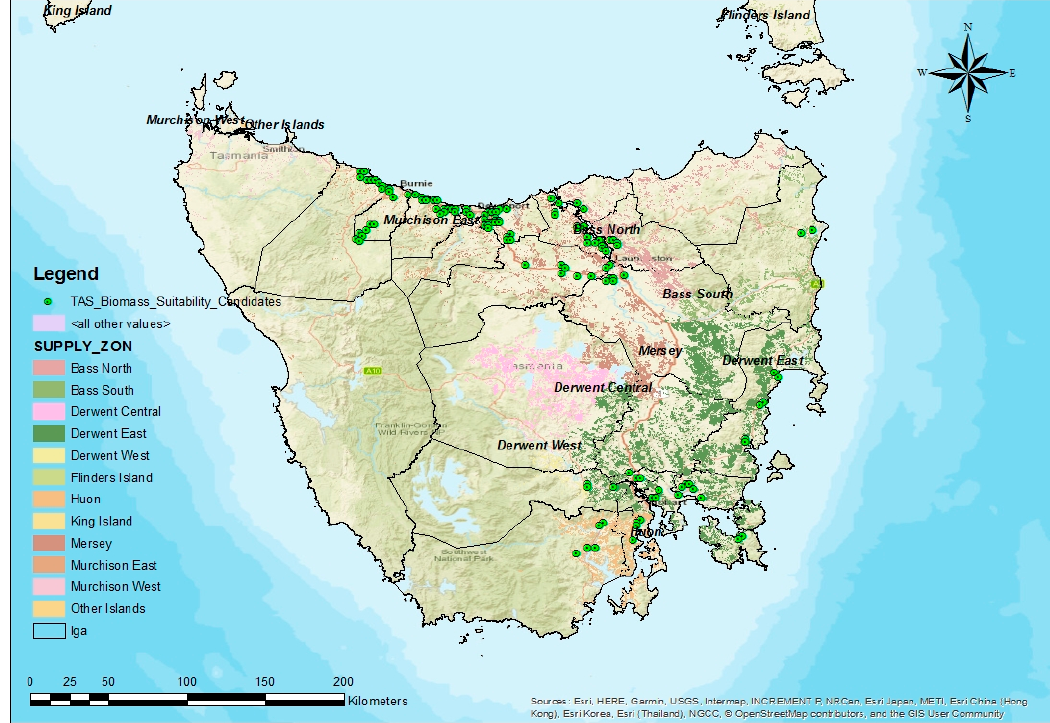
Figure 3. Suitability map with the final potential bioenergy plant locations in Tasmania.